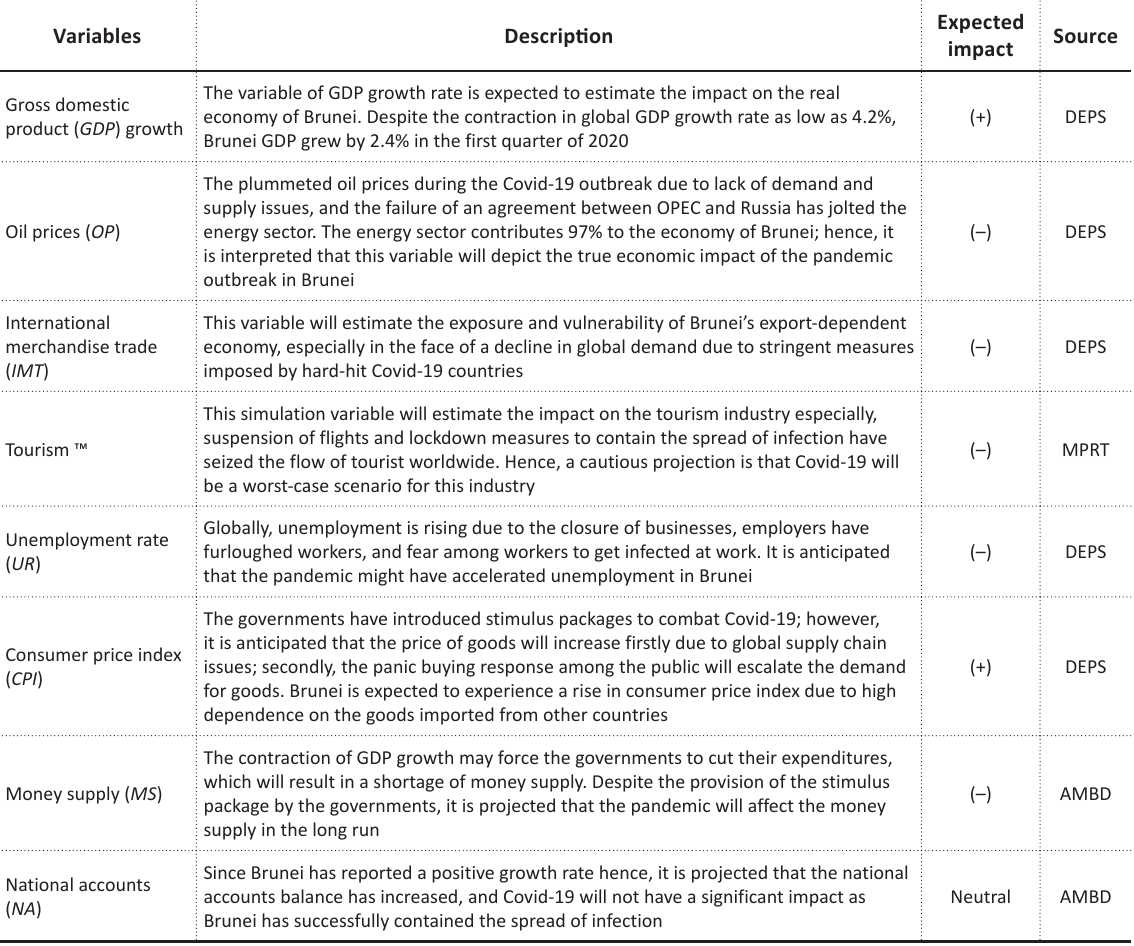
Table 1. Estimation of the variables used in this